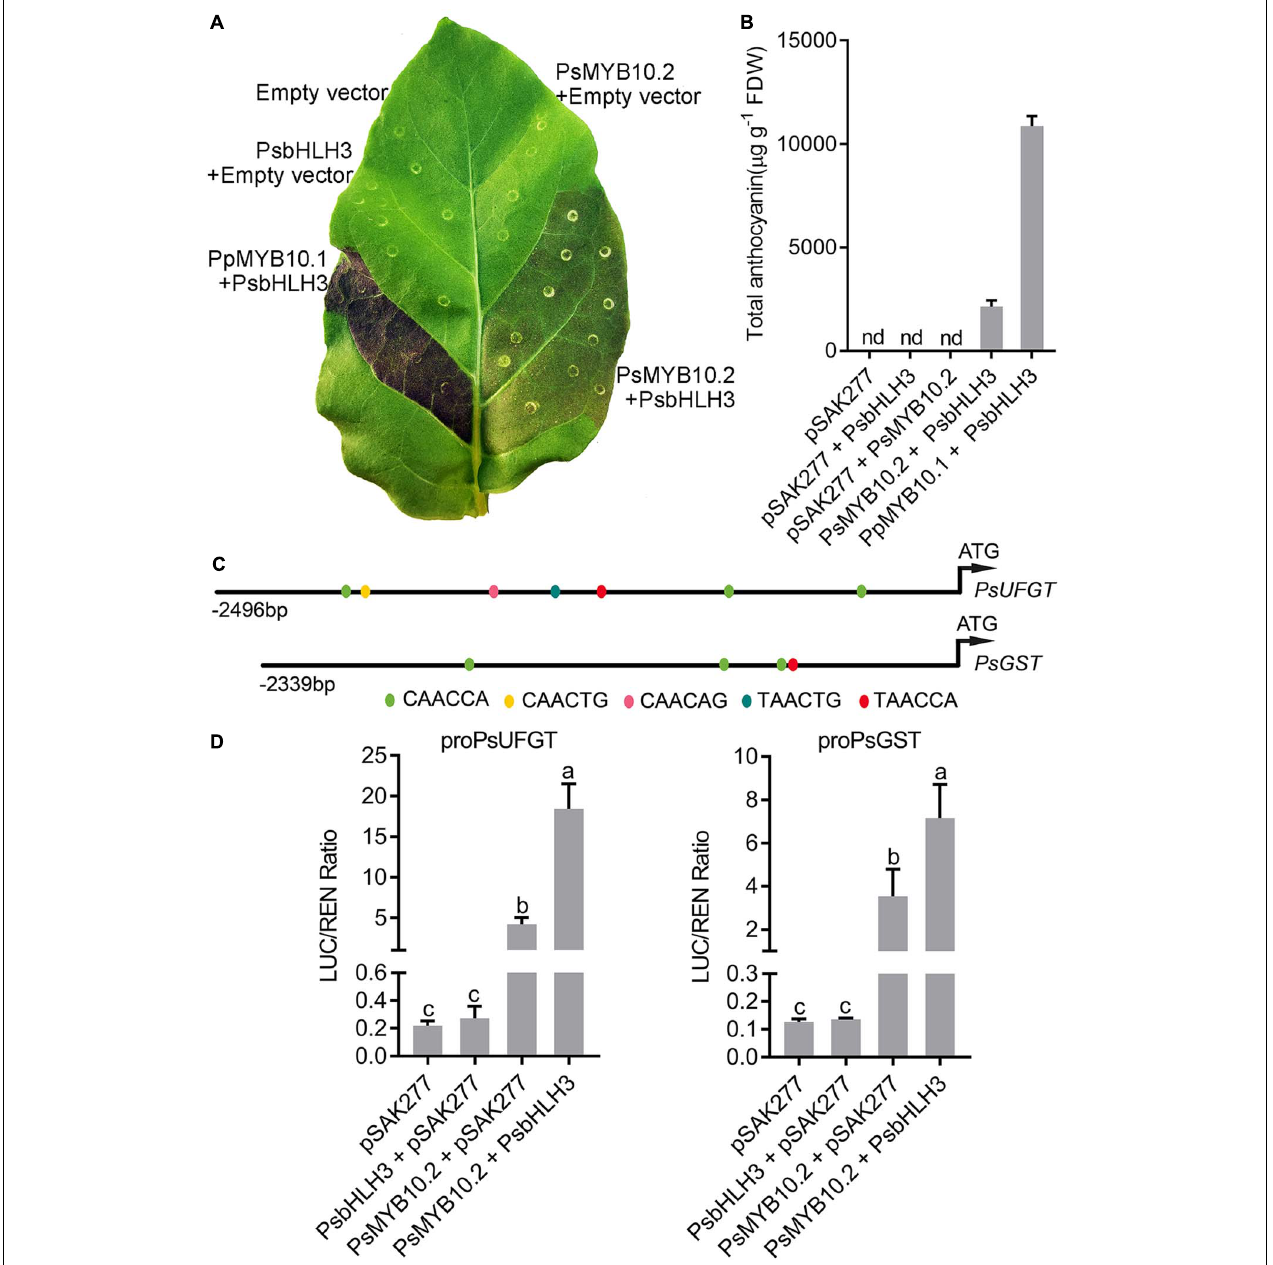
FIGURE 7 | Functional analysis of the PsMYB10.2 gene using transient assay in tobacco. (A) Transient expression of PsMYB10.2 in tobacco leaf. The photo was taken 7 days after infiltration. Peach PpMYB10.1 / PsbHLH3 was used as positive control. (B) Anthocyanin content in transformed leaves of tobacco. Each value represents the mean of three biological replicates. FDW, freeze dry weight. nd, non-detected. (C) Schematic diagram of the PsUFGT and PsGST promoter. The prediction of the cis-acting elements in the promoter of PsUFGT and PsGST was performed using the PlantCARE (http://bioinformatics.psb.ugent.be/webtools/plantcare/html/) database. Color ellipses represent predicted MYB binding sites. (D) Analysis of the interaction of the PsMYB10.2 gene with the promoters of PsUFGT and PsGST genes using dual-luciferase reporter assay Nicotiana benthamiana leaves. Error bars represent the standard errors for three replicates. Different lowercase letters indicate significant differences among treatments according to one-way ANOVA test ( P < 0.05). Means with the same letter are not significantly different at the 0.05